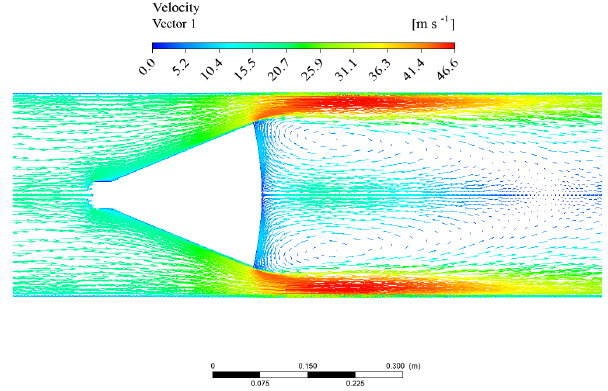
Figure 11. Contour plot of the pressure difference between the original mesh and the refined one, S-G V-Cone.